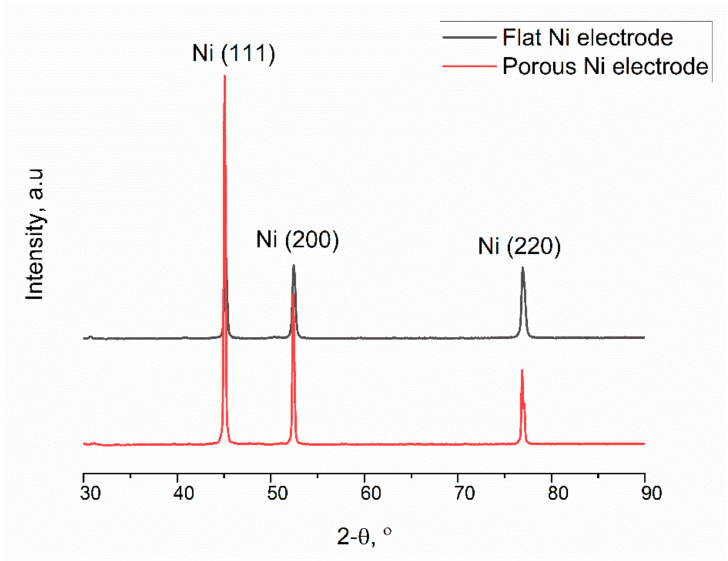
Figure 4. XRD diffraction patterns for the flat Ni substrate (black) and Ni porous electrode (red).